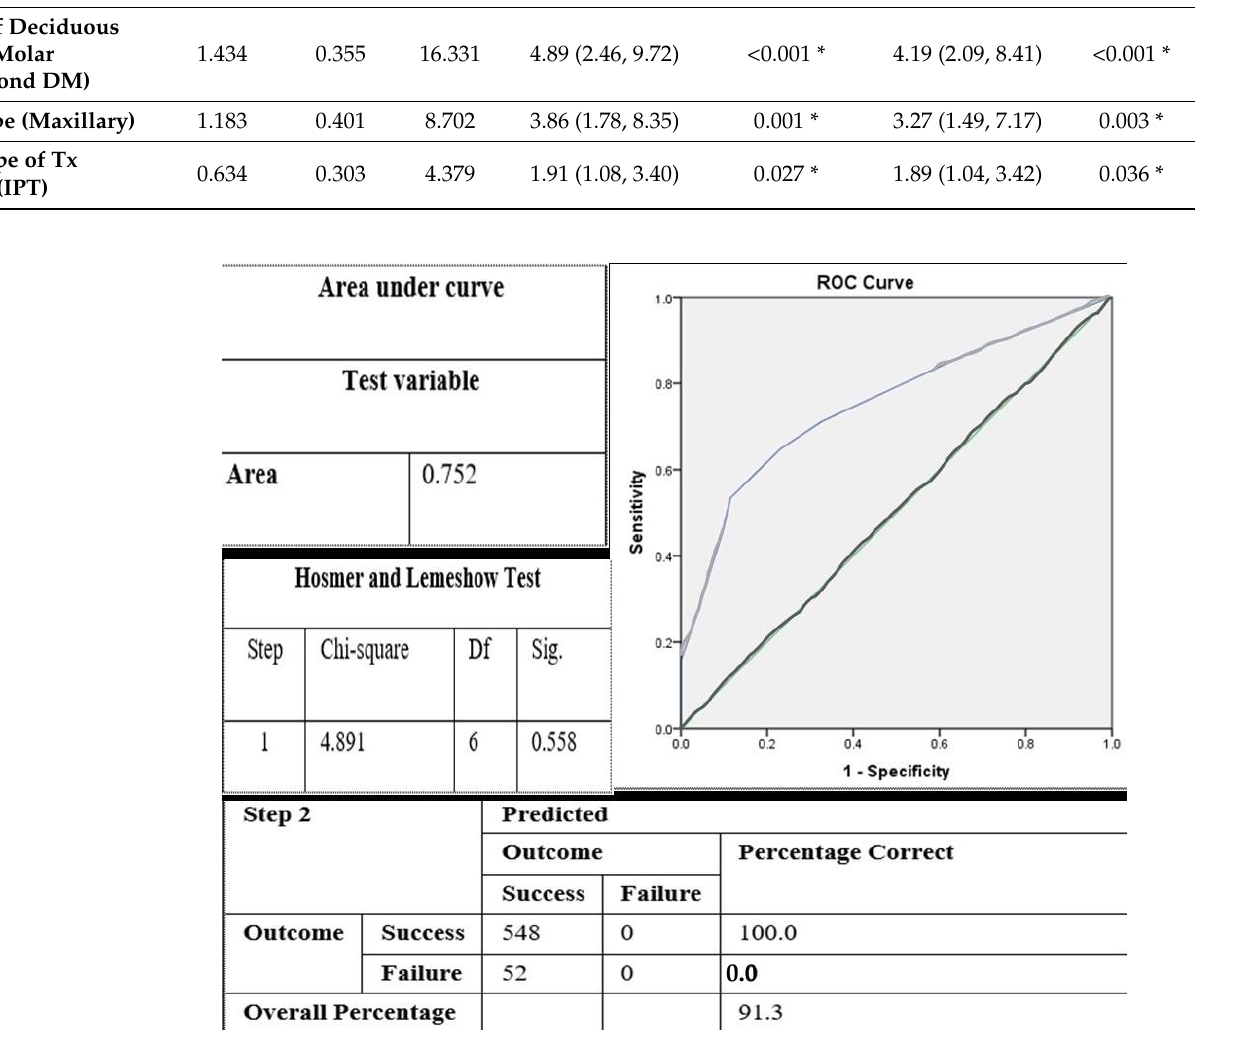
Figure 3. Assessment of goodness of fit of the final logistic regression model.